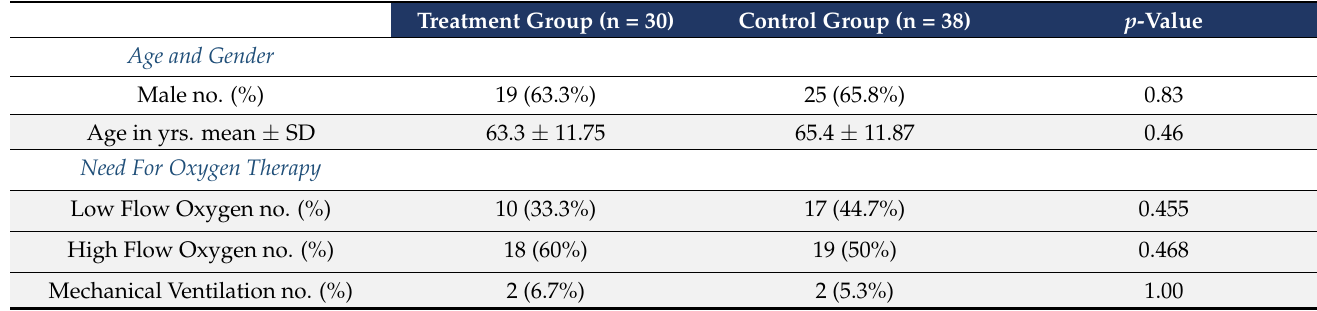
Table 1. Baseline characteristics comparison among treatment and control